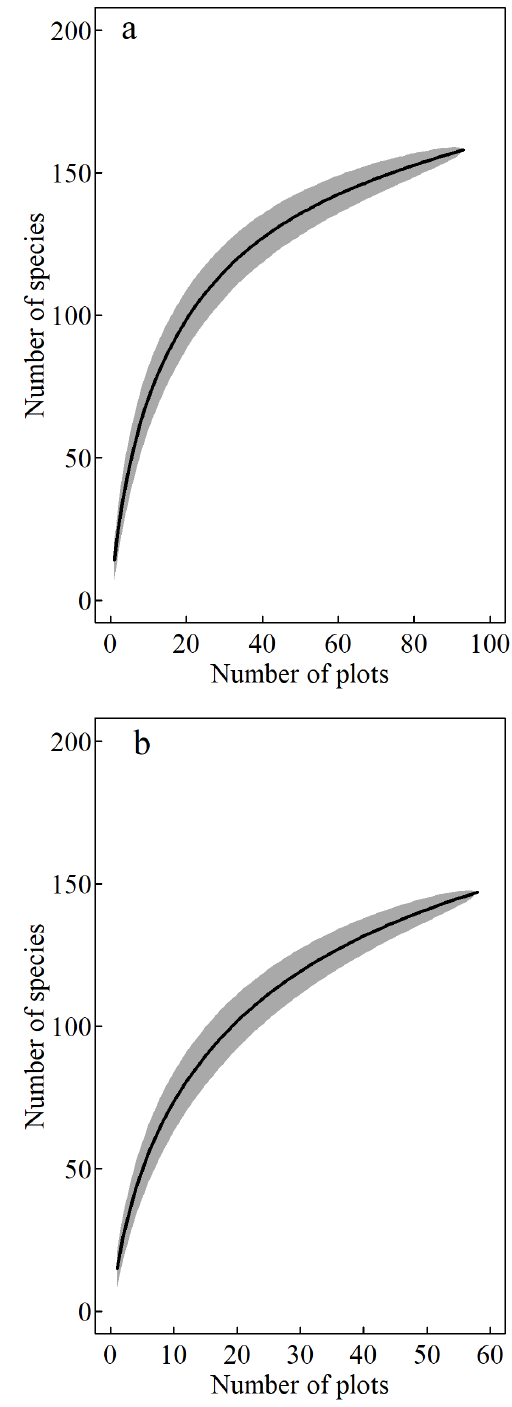
Figure 2. Species accumulation curve for disturbed forest area (a) and undisturbed forest area (b) in 2010, in the Tapajós National Forest, Pará, Brazil. Curve followed by the confidence interval at the 0.05 level of